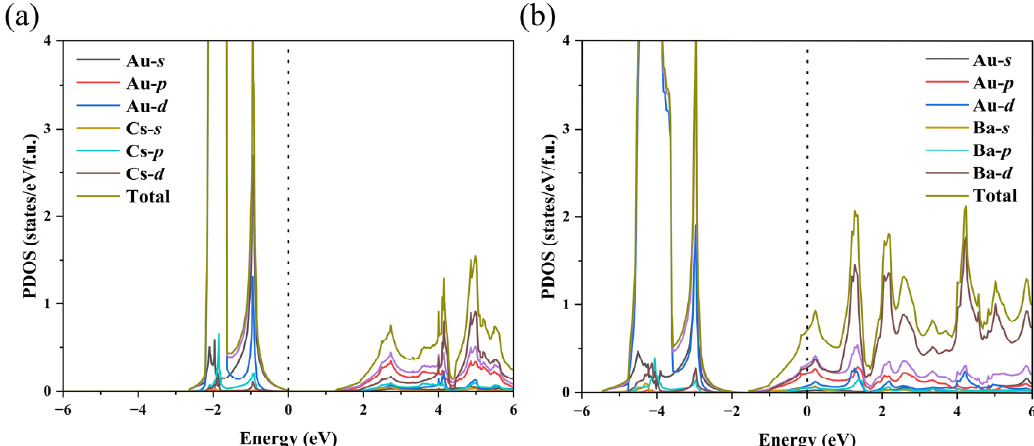
Figure 5. PDOS calculated for CsAu ( a ) and BaAu ( b ) with the CsCl-type structure at 0 GPa.